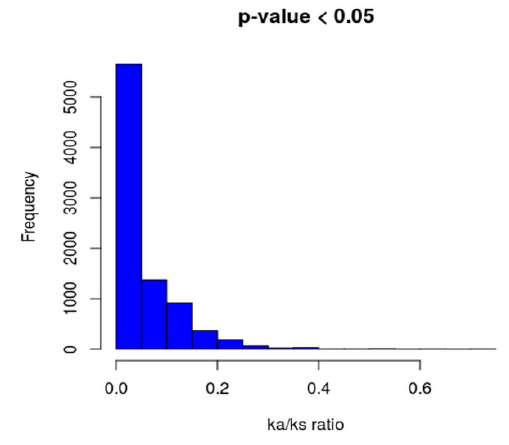
Figure 4. Histogram illustrating Ka / Ks ratios of each core gene.